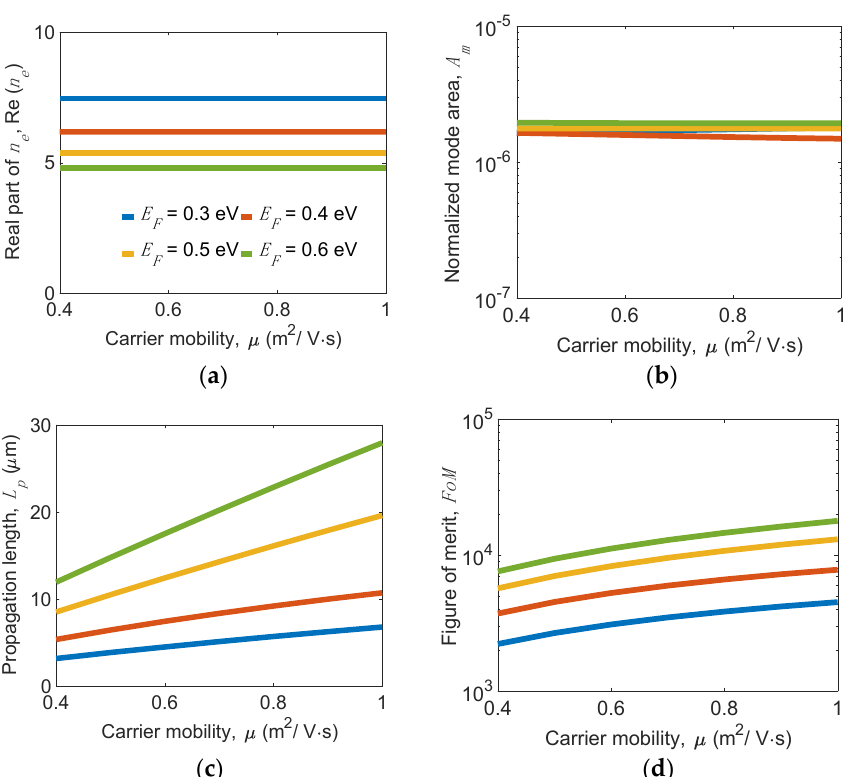
Figure 11. Plots of ( a ) real part of effective index n e , Re( n e ), ( b ) normalized mode area, A m , ( c ) propagation length, L p , and ( d ) figure of merit, FoM, of the present structure versus carrier mobility, µ , for several E F ’s at w g = 200 nm, w r = 10 nm, h r = 30 nm, t Si = 5 nm, t d = 5 nm, and f = 20